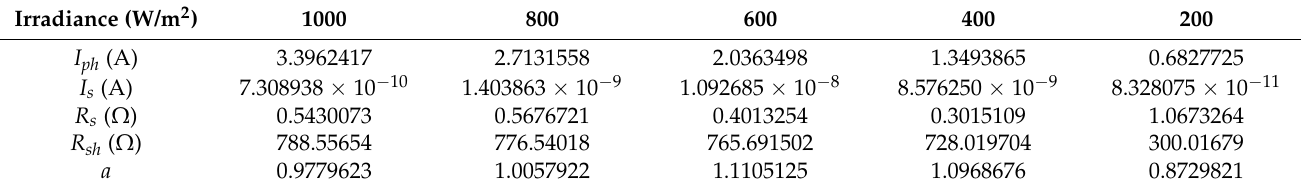
Figure 10. I-V characteristics measured and calculated, respectively, for the thin-film SM55 PV panel in different temperature conditions. Table 5. Parameter estimation values for I- and P-V characteristics in Figures 7 and